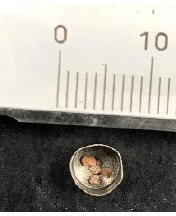
Figure 16. Picture of black particles of Ofunato Ca(OH) 2 ) after a 4th hydration in the TGA-51 system. Table 5. Identified elements in Ofunato Ca(OH) 2 (white particles) after the 1st hydration in the TGA-51 system and decarbonization in a muffle furnace (measured by Energy Dispersive X-ray Spectroscopy). Fitting Coefficient: 0.69